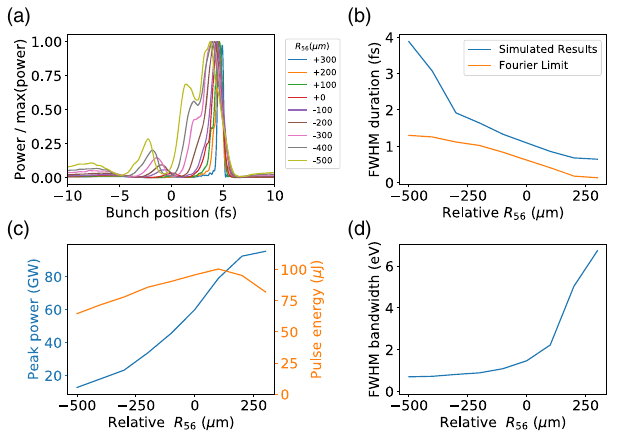
FIG. 5. Outcoupled x-ray FEL pulse duration vs relative change to DL2 R 56 . Outcoupled power profiles (a) show a linearly shrinking pulse duration (b) without significantly changing the overall pulse energy (c). The pulse bandwidth (d) significantly exceeds the reflective bandwidth of the mirrors for each shot.